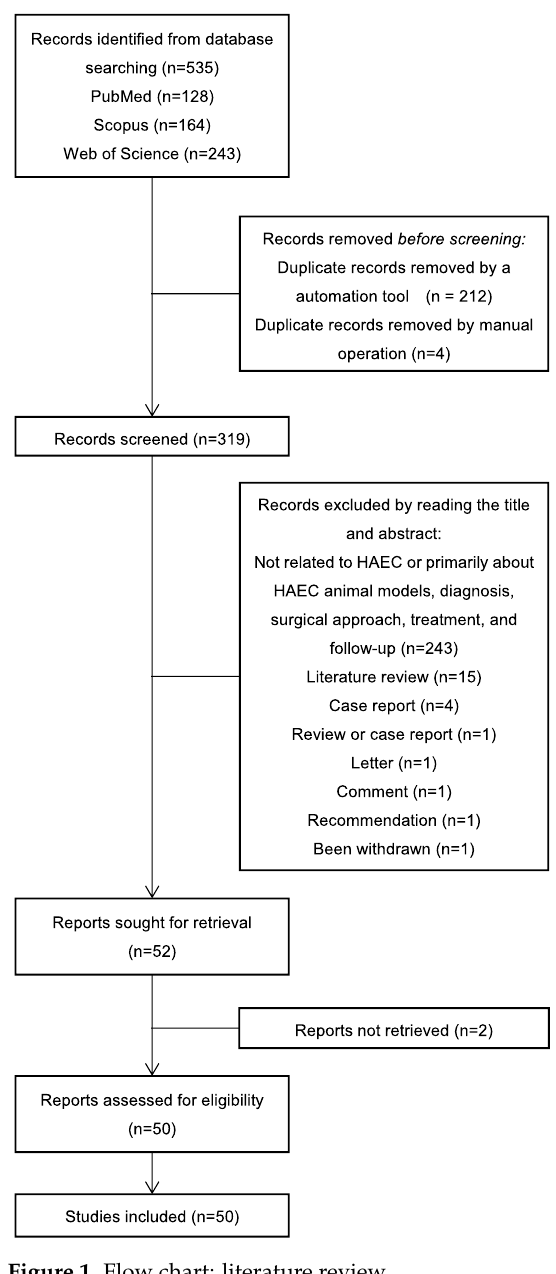
Figure 1. Flow chart: literature review.